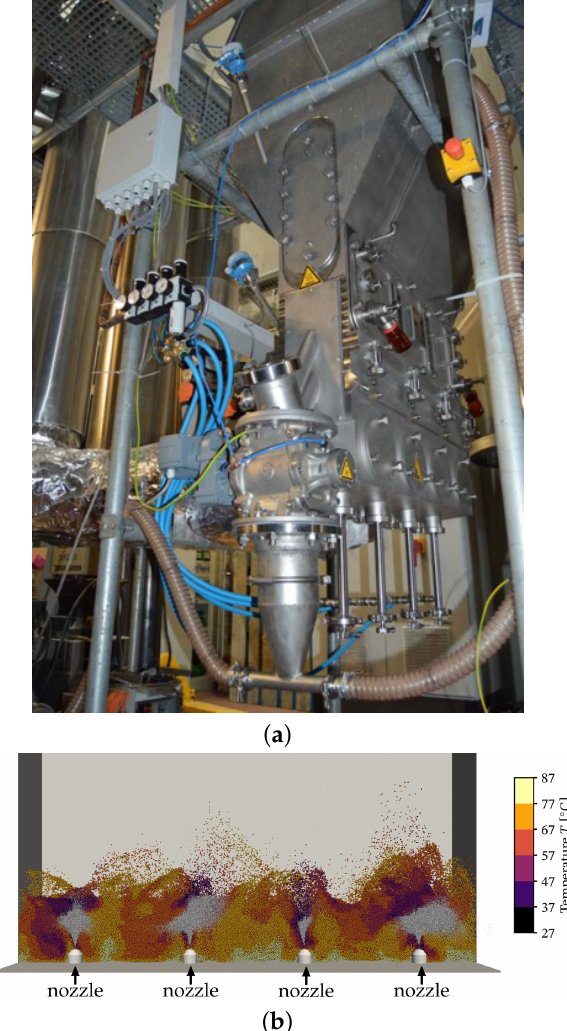
Figure 11. Photo of the GF25 plant and a snapshot of a representative simulation showing the injection of droplets through all four nozzles into the bubbling fluidized bed. ( a ) Photo of the Glatt GF25 pilot-scale granulator plant. ( b ) Simulation snapshot of the GF25 simulations, showing the temperatures of the particles, and the positions of the droplets, indicated in